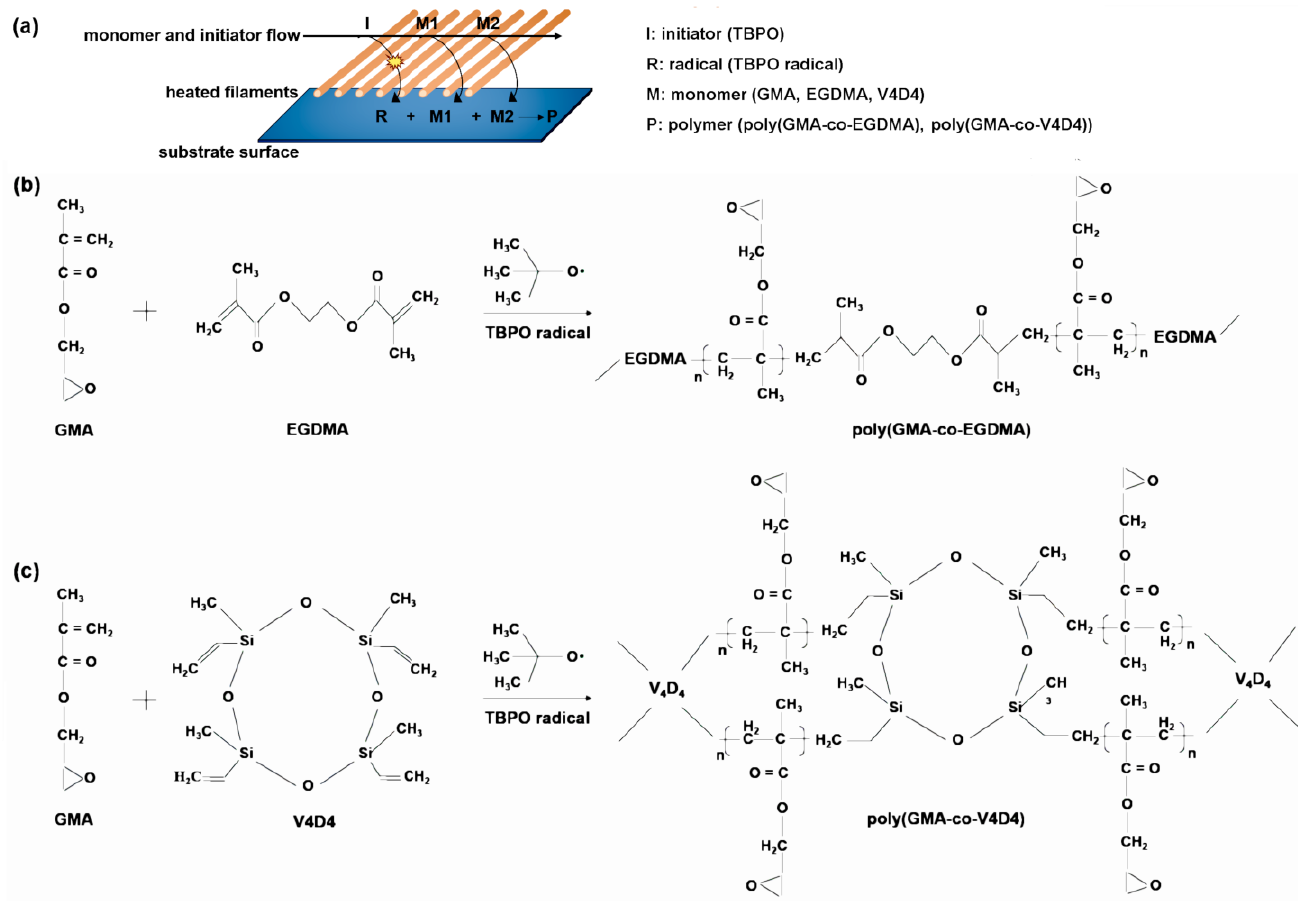
Figure 3. Schematics of ( a ) iCVD process, ( b ) poly(GMA-co-EGDMA) and ( c ) poly(GMA-co-V4D4) copolymer film synthesis.